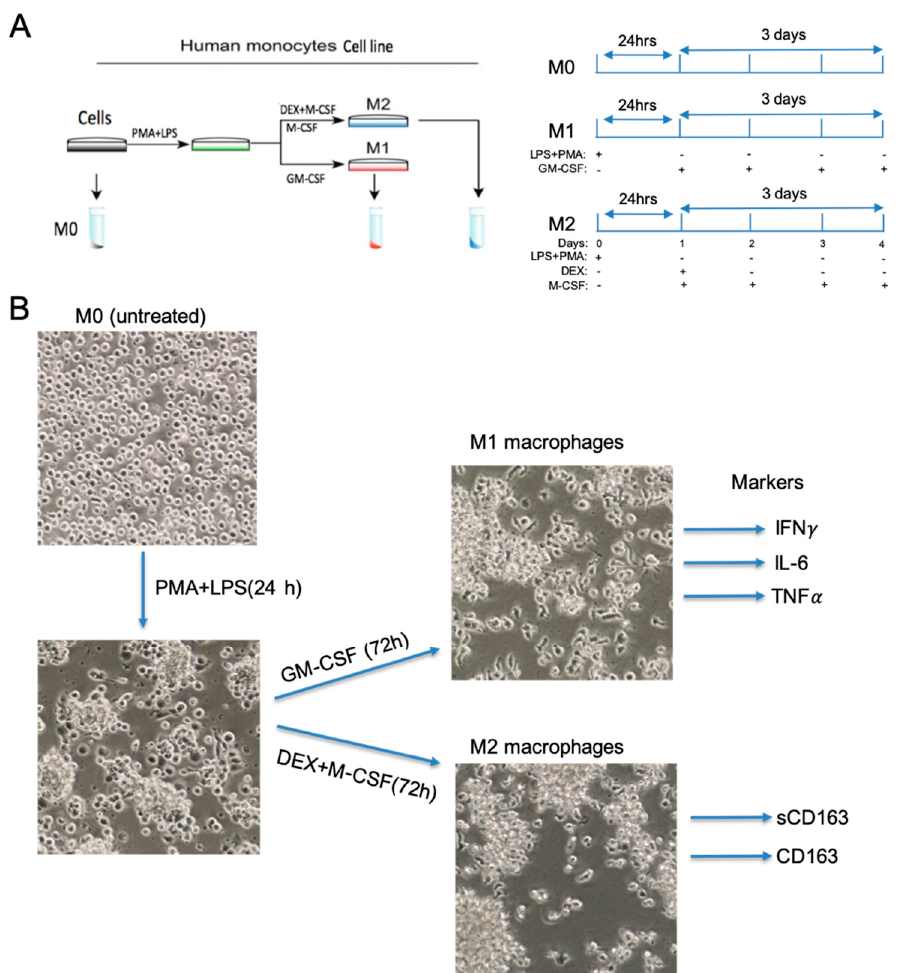
Figure 1. Differentiation of MonoMac-1 cells into functional M1 and M2 macrophage phenotypes. ( A ) Schematic presentation of MonoMac-1 differentiation and growth conditions of cells. MonoMac-1 cells (untreated M0) were first activated by phorbol 12-myristate 13-acetate (PMA) (20 ng/mL) and LPS (10 ng/mL) treatment for 24 h. The cells were then treated with granulocyte-macrophage colony- stimulating factor (GM-CSF) (10 ng/mL) for 72 h to differentiate into M1 type macrophages. For the M2 phenotype macrophages, cells were treated with macrophage colony-stimulating factor (M-CSF) (5 ng/mL) and dexamethasone (DEX) (200 ng/mL) for 72 h. ( B ) Morphological changes of macrophages with differentiation. Phase contrast images were taken at 20X magnification. M1 (IFN- γ , interleukin (Il)-6, TNF- α ) and M2 (CD163 and sCD163) macrophage markers are